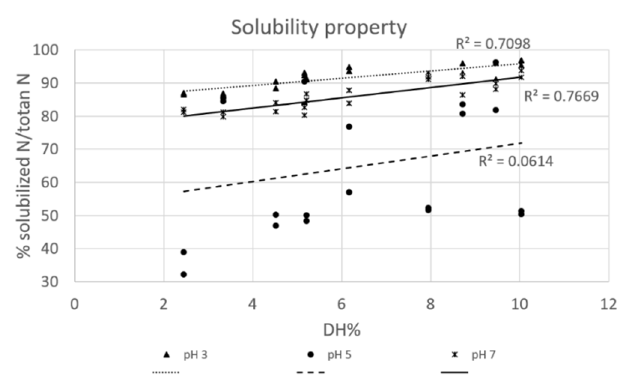
Figure 2. Solubility properties of 1% of protein hydrolysates (average ionic strength 2.8 ± 0.2 mS/cm) reported as % of solubilized N in function of DH%.